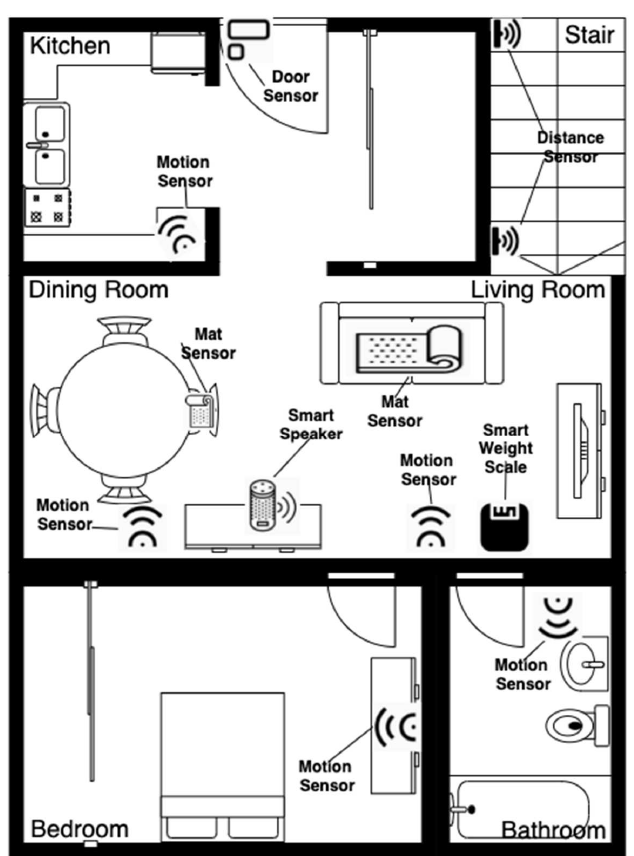
Figure 3. Sensor setup layout in